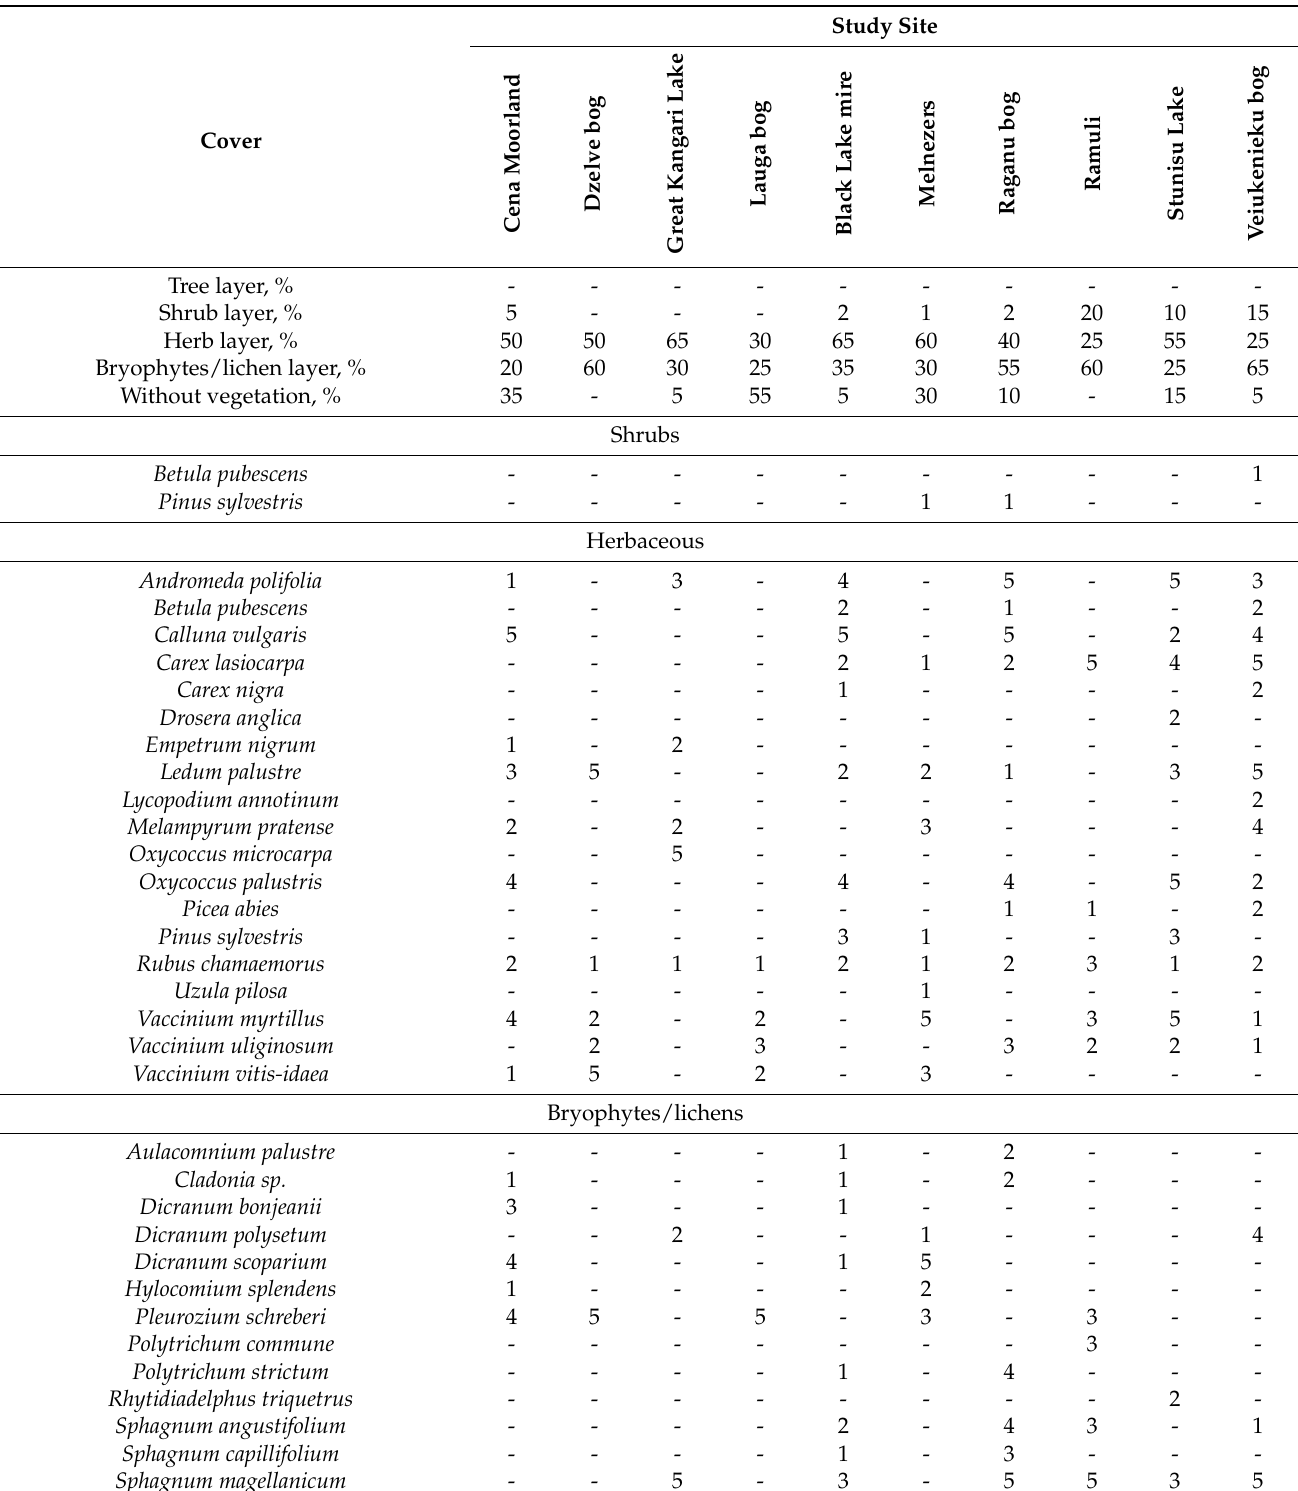
Table 1. Vegetation composition according to Braun-Blanquet scale and vegetation cover of layers (%) in cloudberry study sites in Latvia,